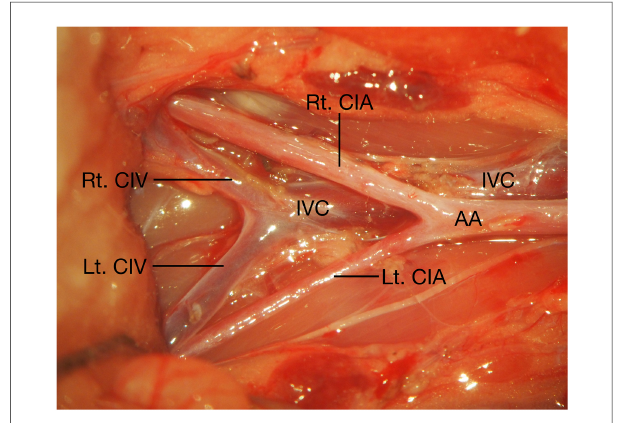
FIGURE 2 Anatomy of the CIA, CIV, IVC, and AA related to the end-to-side microvascular anastomosis using rat CIA. AA, abdominal aorta; CIA, common iliac artery; CIV, common iliac vein; IVC, inferior vena cava; Lt., left; Rt.,